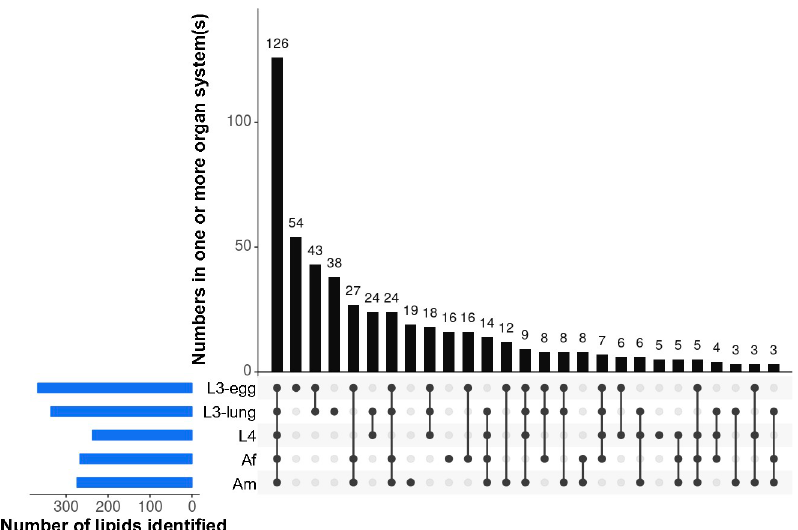
Fig 1. The presence and numbers of lipids identified in five different developmental stages/sexes of Ascaris suum (i.e. infective third-stage (L3-egg), lung stage L3 (L3-lung) and fourth-stage (L4) larvae; female (Af) and male adults (Am)). Connected dots display shared lipid species between or among developmental stages/sexes, and the total number of lipid species in a particular stage/sex is shown (bottom left corner). https://doi.org/10.1371/journal.pntd.0008848.g001 Fatty acyl composition of the lipidome of Ascaris suum The analysis of fatty acyl compositions revealed that the lipidome of A . suum contained a large section of long-chain ( > 12 carbons), even-numbered and unsaturated fatty acyls, which con- tributed 97%, 88% and 62% to the overall fatty acyl composition, respectively (Table 2). In